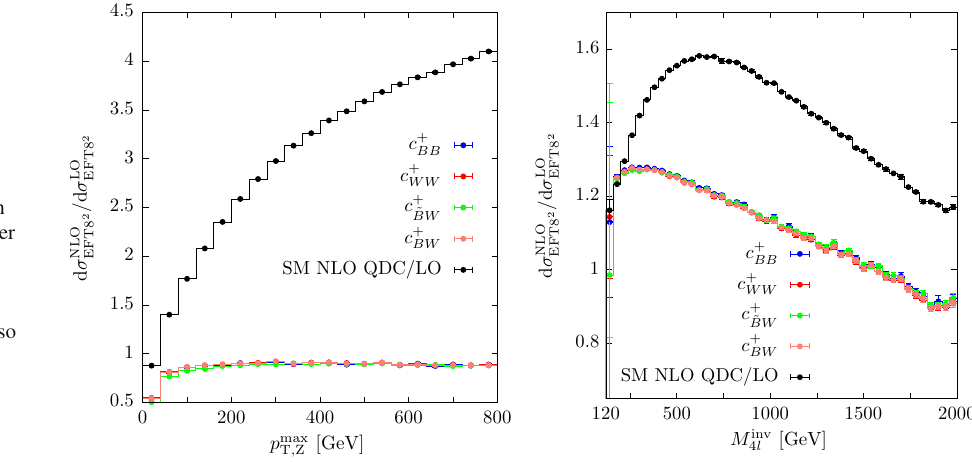
Fig. 22 Ratio between the EFT8 2 contribution to the process pp → e + ν e μ + μ − computed at NLO QCD ( σ NLO ) and LO ( σ LO ) EFT8 2 EFT8 2 accuracy as a function of the transverse momentum of the hardest Z boson (left plot) and as a function of the four-lepton invariant mass (right plot) under the event selections of Eq. (4.11). The ratio between the SM predictions at NLO QCD and at LO accuracy is also shown (black lines) 0